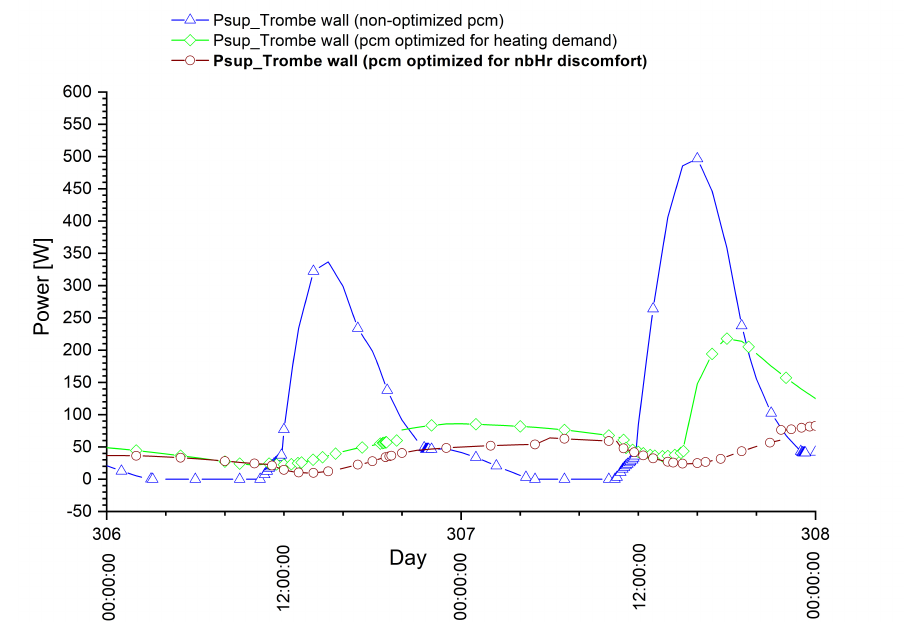
Figure 22. Comparison of the power supplied by the solar Trombe wall installed with the optimized and non-optimized PCM.